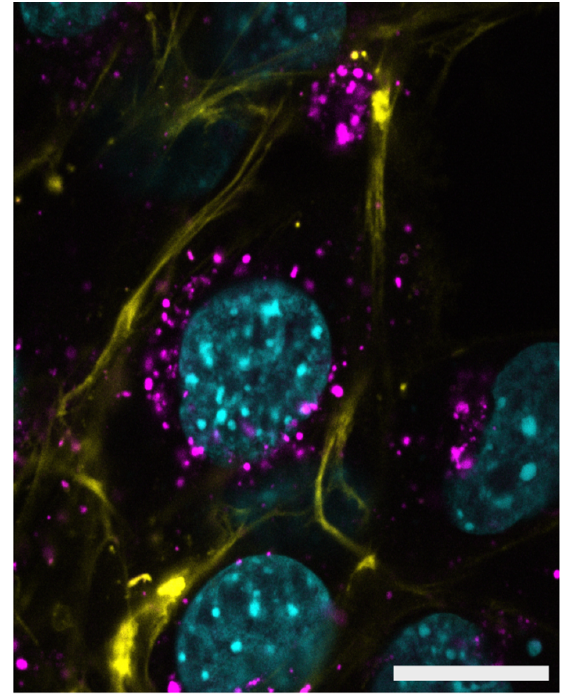
Figure 4: Representative confocal microscopy section showing the FAM vesicles inside the cell. Mouse NIH 3T3 fibroblasts were incubat- ed with 20 µM of the FAM-labelled 4Ts-ON for 12 hours, then stained with CellBrite Fix 640 (Biotium) to identify the cell membrane before fixation with 4% paraformaldehyde. Nuclear DNA was then stained with Hoechst 3342 and images collected with a Leica SP5 DM6000B scanning confocal microscope. Overlaid pseudo-coloured panels of a section are shown: nuclear DNA (blue), 4Ts-FAM/ON (magenta), cell membrane (yellow). Scale bar: 20 μ